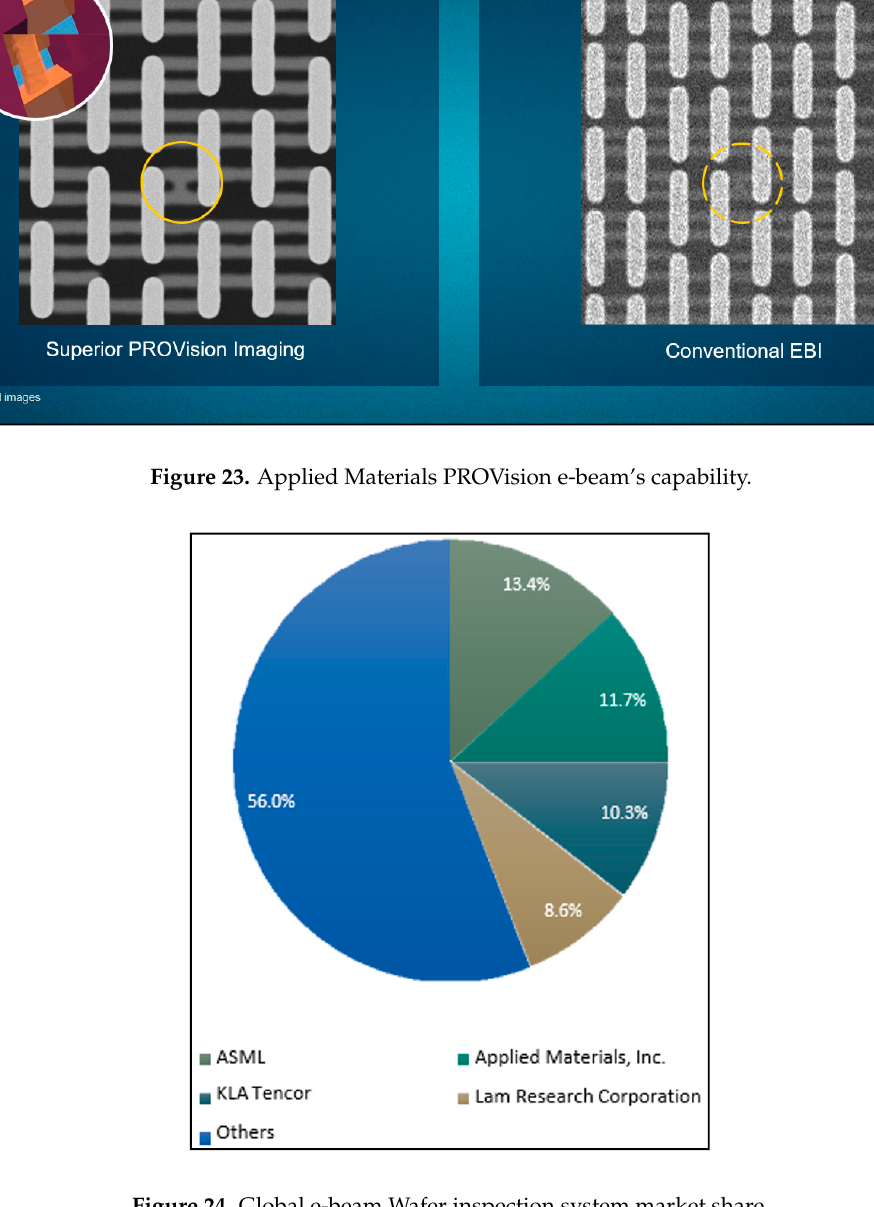
Figure 24. Global e-beam Wafer inspection system market share.